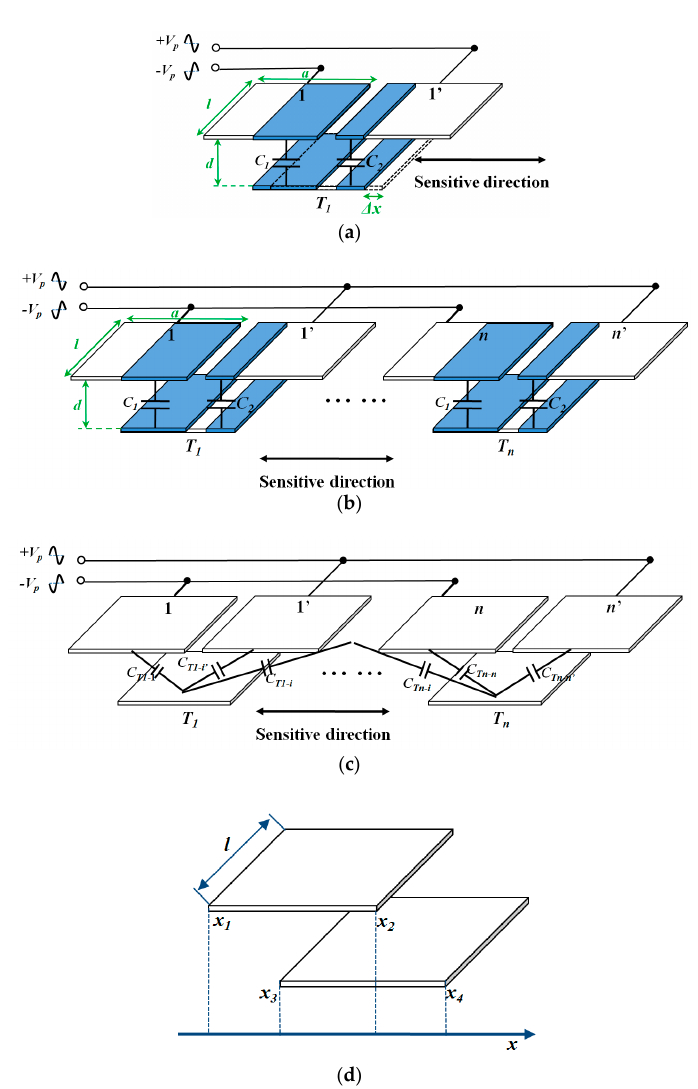
Figure 3. Model of the area-changed capacitive transducer. ( a ) Single area-changed capacitive displacement transducer; ( b ) Encoder-like area-changed capacitive transducer using the ideal plane-parallel capacitor model; ( c ) Encoder-like area-changed capacitive transducer model considering the fringe effect; ( d ) Model of Heerens’s formula for calculation fringe effect.